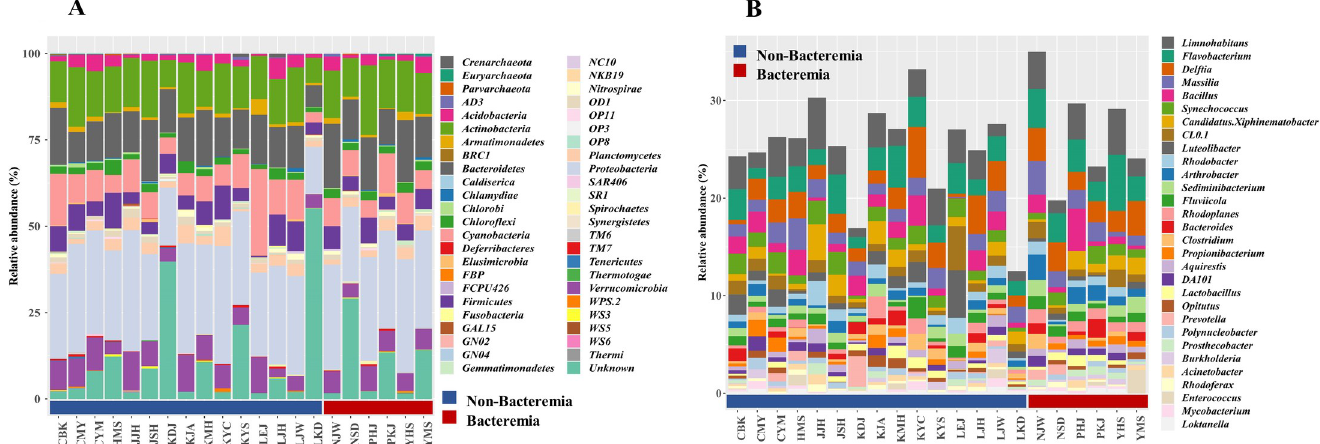
Fig 2. Taxonomic profiles of extracorporeal membrane oxygenation samples. (A) Phylum level taxonomic profile. (B) Genus level taxonomic profile.